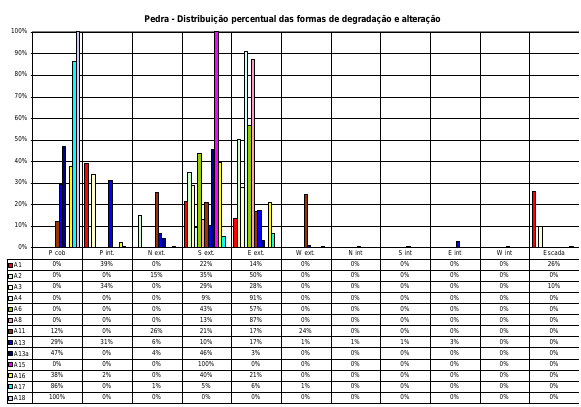
Figure 12. Percentage distribution of forms of decay and alteration (Genin, 2002b).